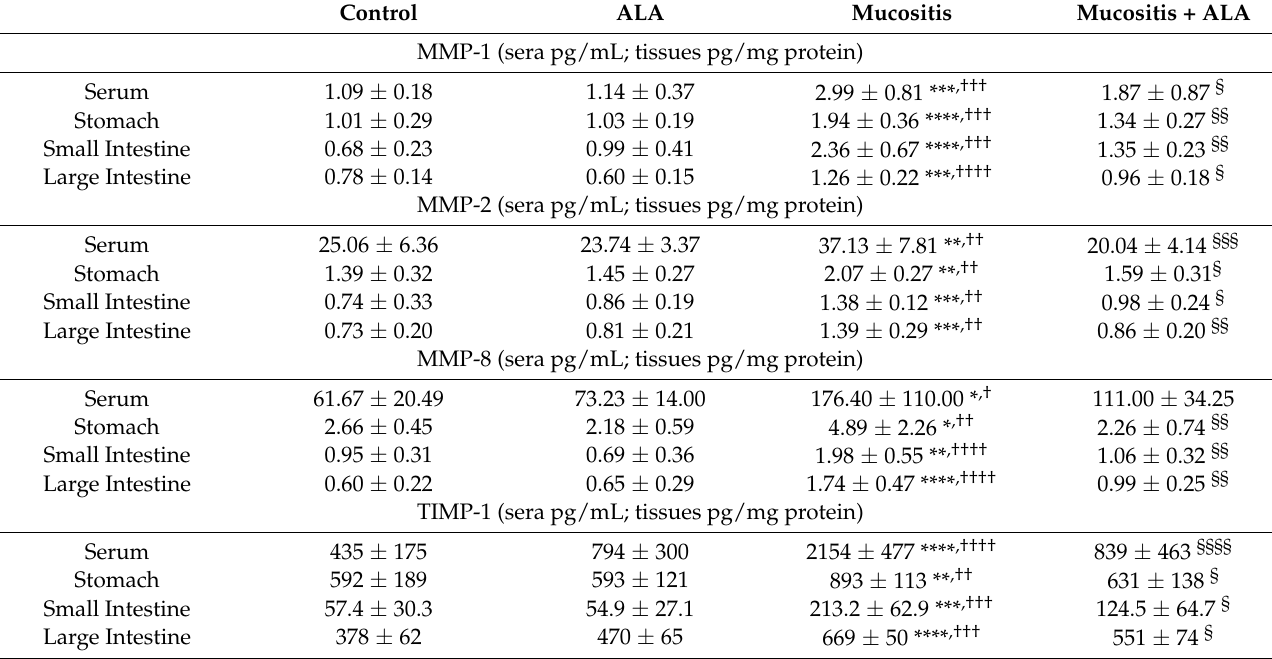
Table 2. Results of MMPs and TIMP-1 in sera and tissues (Mean ±